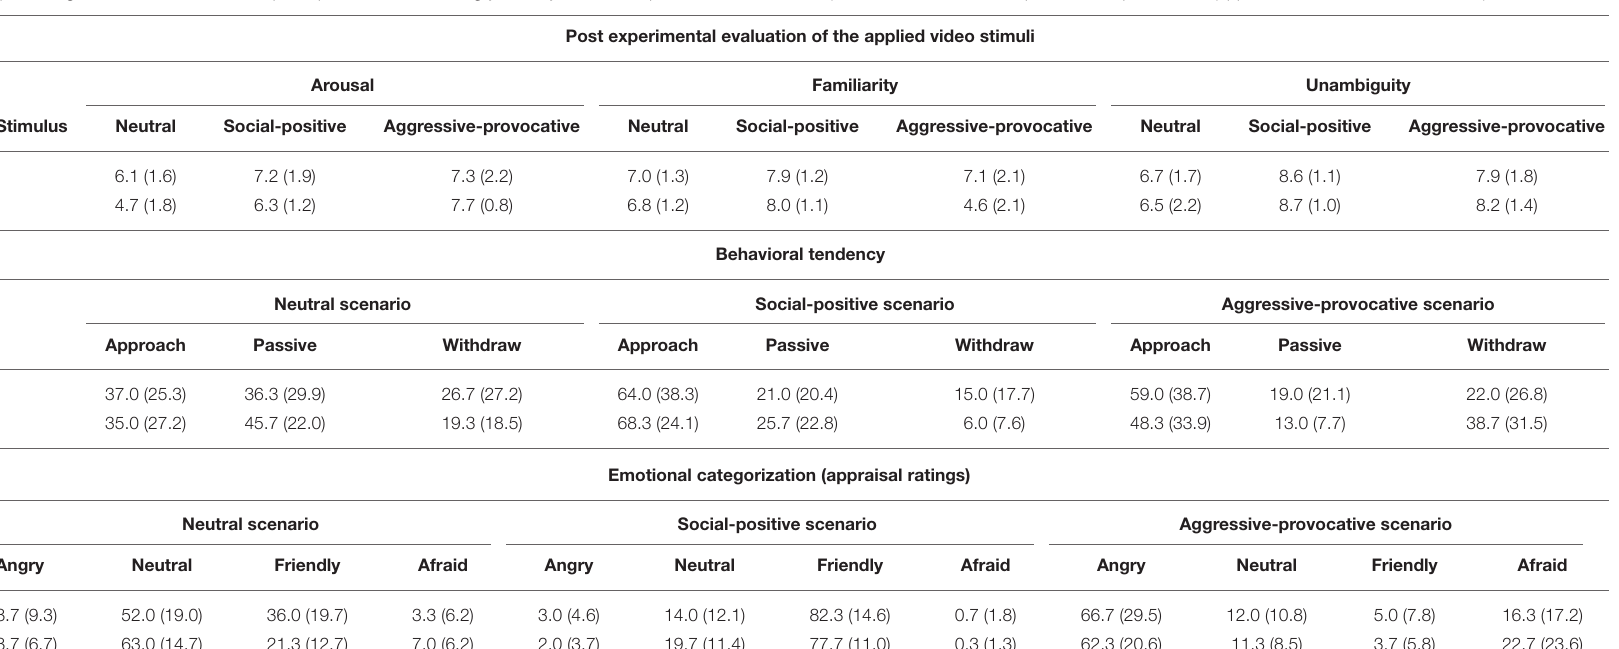
TABLE 1 | Post experimental (after MRI-scanning session) evaluation of the applied video stimuli according to arousal (11 level scale: 0–10), familiarity (11 level scale: 0–10), unambiguity (11 level scale: 0–10), the situation-related behavioral tendency (percentage of interactions, in which participants decided to withdraw from, to behave passively in or to approach the scenario), and situation-related emotional appraisal rating (percentage of interactions for which participants rated to felt angry, friendly, afraid or experience a neutral mood); standard deviations are presented in parenthesis (upper values: EG; lower values: